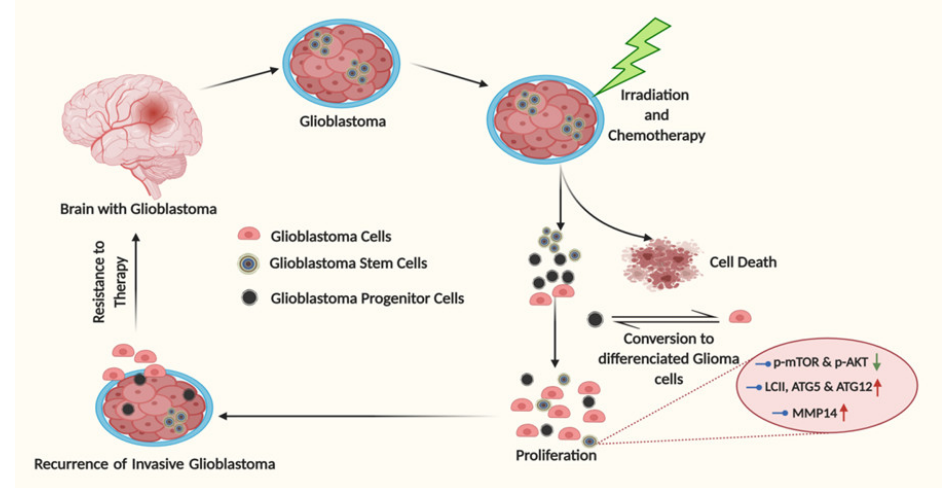
Figure 4. Tumor progression and recurrence in glioblastoma tumors mediated by glioma stem cells (GSCs). GSCs showed self-renewal and induced glioblastoma progenitor cells generation, which further transformed into differentiated glioblastoma cells. This differentiation causes higher proliferation and invasive glioblastoma recurrence, which leads to resistance towards different therapeutics. GSCs are capable to re-initiate the progression of tumors. Pathways, including mTOR, AKT and MMP14, and the molecules related to autophagy, including LCII, ATG5 and ATG12, get altered in GSCs. This figure illustrates the involvement of cellular flexibility in recurrence of illness and could help to develop new therapeutics to inhibit recurrence.